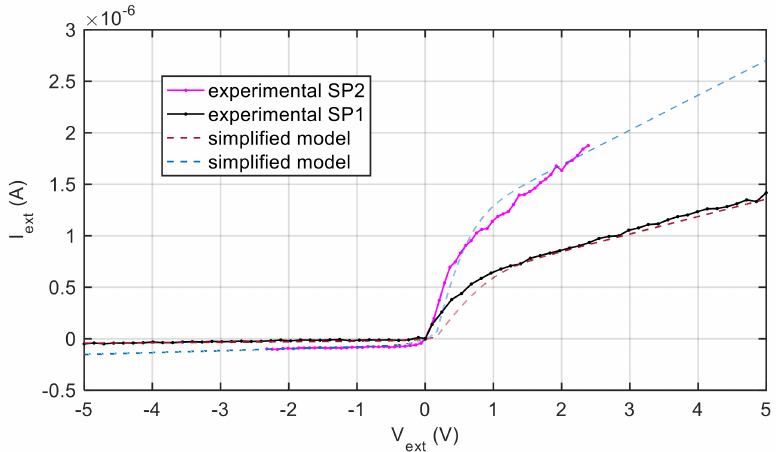
Figure 8. Experimental results (lines with markers) obtained using two different spark plugs (SP1—turbine spark plug and SP2—automotive spark plug), placed at 6 cm from the torch nozzle. Dashed lines: model linearized at V W = 5